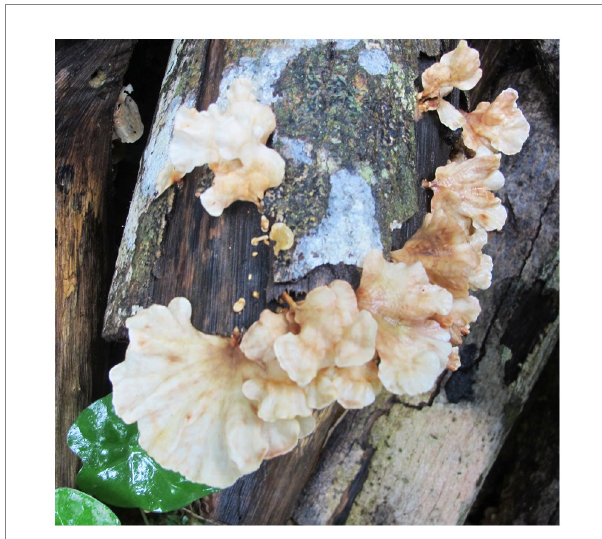
FIGURE 5 Basidiomata of Podoscypha subinvoluta